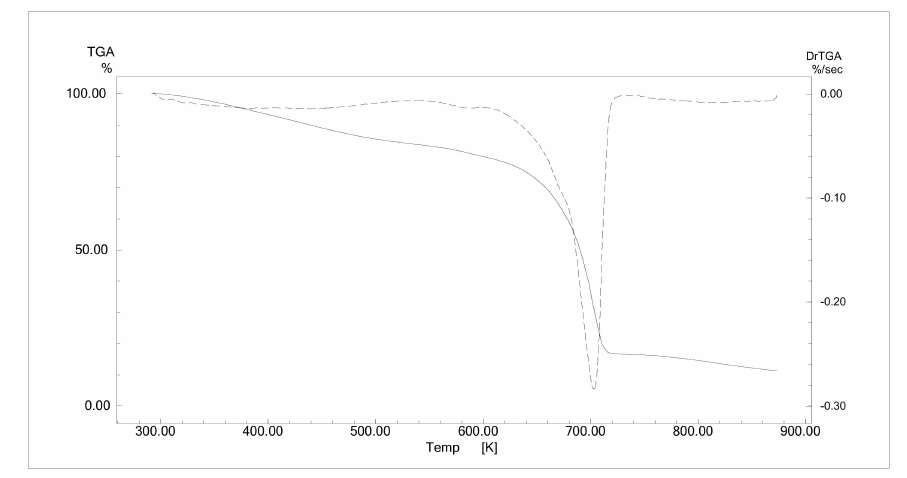
Figure 6. Dynamic TGA analysis of tetrabutylphosphonium bromide (TBPBr): p -toluenesulfonic acid (PTSA) (1:1). The solid line illustrates the reduction of DES mass, while the dashed line illustrates the degradation